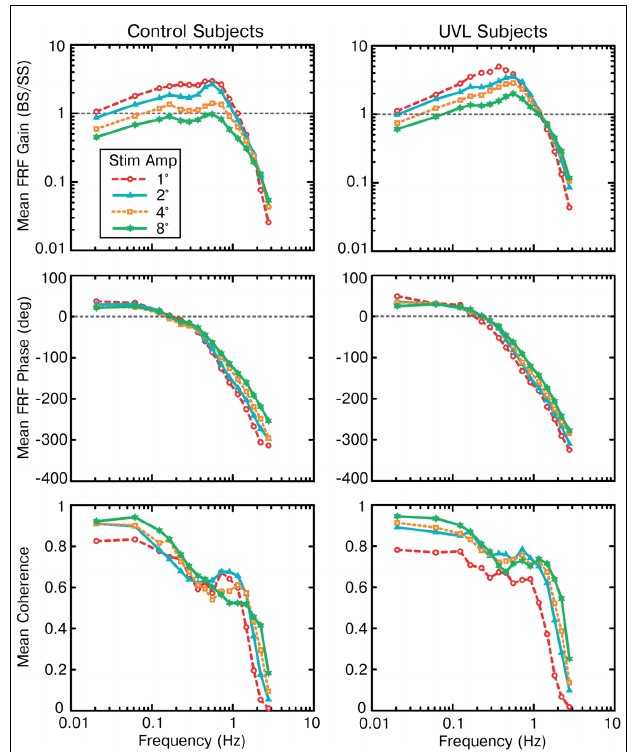
FIGURE 3 | Group mean frequency response functions (FRFs expressed as gain and phase functions) and coherence functions of medial–lateral body-sway responses to four amplitudes of pseudorandom surface-tilt stimuli for control (left column) and unilateral vestibular loss subjects (right